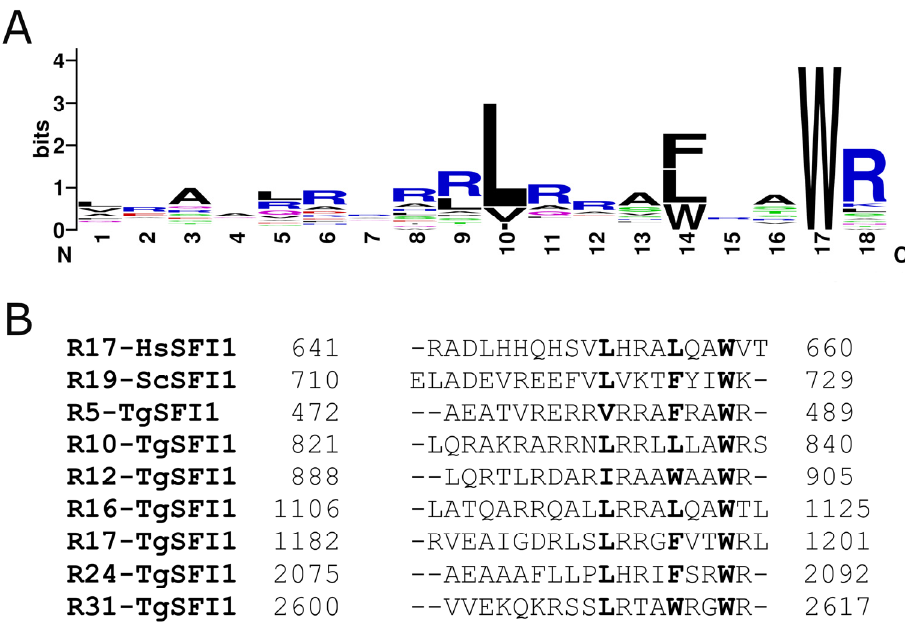
Figure 1. Repeat centrin-binding sequences of TgSFI1. ( A ) Sequence logo of the SFI1 repeats in T. gondii . The total height of all the stacked letters at a single position is proportional to the amount of conservation of the residue [41], and the height of each stacked letter is proportional to the frequency with which the amino acid is observed. ( B ) The seven peptides used in this work, localized in distinct positions in the TgSFI1 sequence, are aligned with the consensus repeat sequences of the human (HsSFI1) and yeast SFI1 (ScSFI1) proteins. The hydrophobic triad is in bold (reverse orientation).